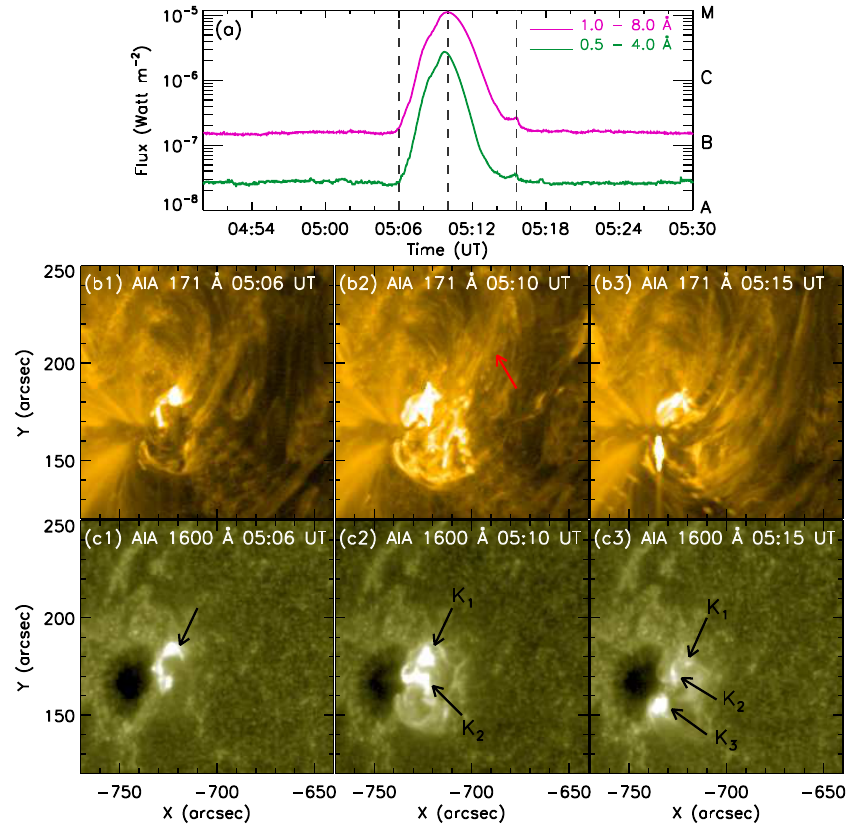
Figure 1. ( a ) Light curves of the flare observed by GOES in two X-ray wavebands. Middle and bottom panels (i.e., panels ( b1 – b3 ) and ( c1 – c3 )): Snapshots of the flare evolution at the times indicated by the vertical dashed lines in panel ( a ). The red arrow in panel ( b2 ) indicates the mass ejected out of the flaring region. K 1 , K 2 , and K 3 are three flare kernels shown by the black arrows in the bottom